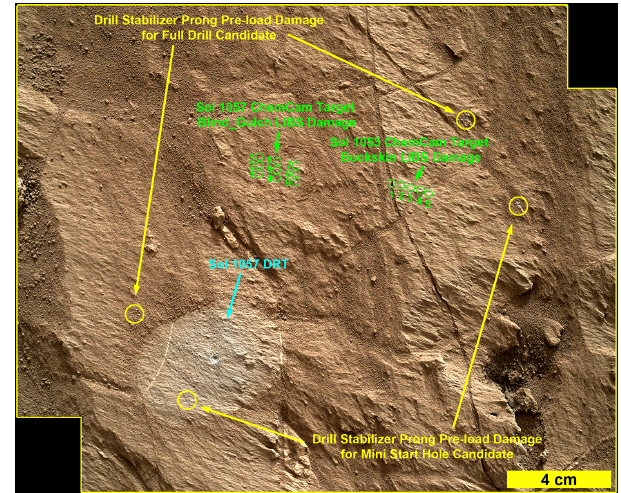
Figure 5. MAHLI image mosaic documenting the planning effort for placement of drill hardware, acquired on sol 1057 (28 July 2015) in preparation for drilling the rover team’s Buckskin drill target. Such imaging for drill activity planning is commonly ac- quired at 35cm distance for accurate placement of the drill stabi- lizers and drill, and for confirmation that drill activities were ex- ecuted nominally and results were as expected. In this diagram, LIBS Damage refers to surfaces destructively investigated using the rover’s ChemCam Laser-Induced Breakdown Spectrometer; DRT refers to a spot swept clean of dust by the rover’s Dust Removal Tool; Blind_Gultch and Buckskin are names assigned by the team to the geologic targets investigated. Illuminated by sunlight from the top, this is a composite of images